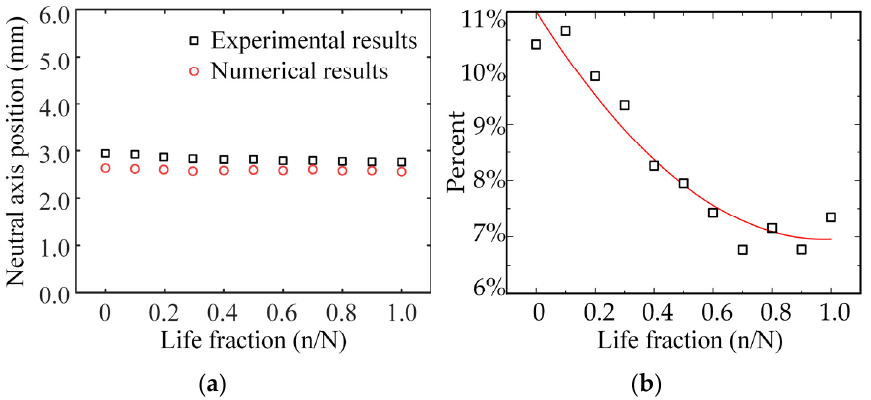
Figure 11. The comparison of experimental and simulation results. The position ( a ) and the deviation ( b ) of the neutral axis.